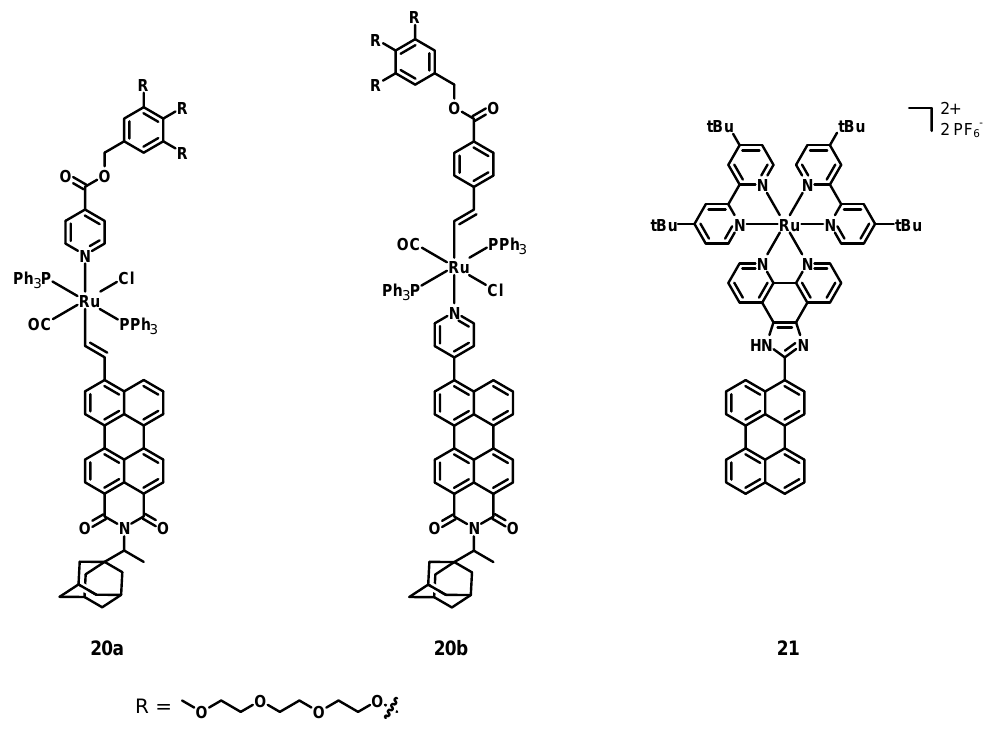
Figure 9. Structures of complex 20a – b and 21 . In 2022, Rau, Tschierlei et al. [53] synthesized, characterized, and tested the